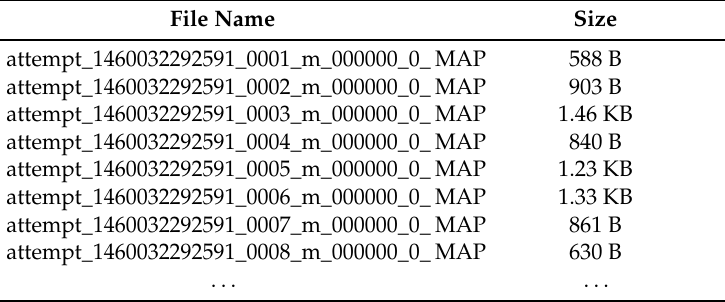
Table 3. Data of Map Tasks Collected by Modified